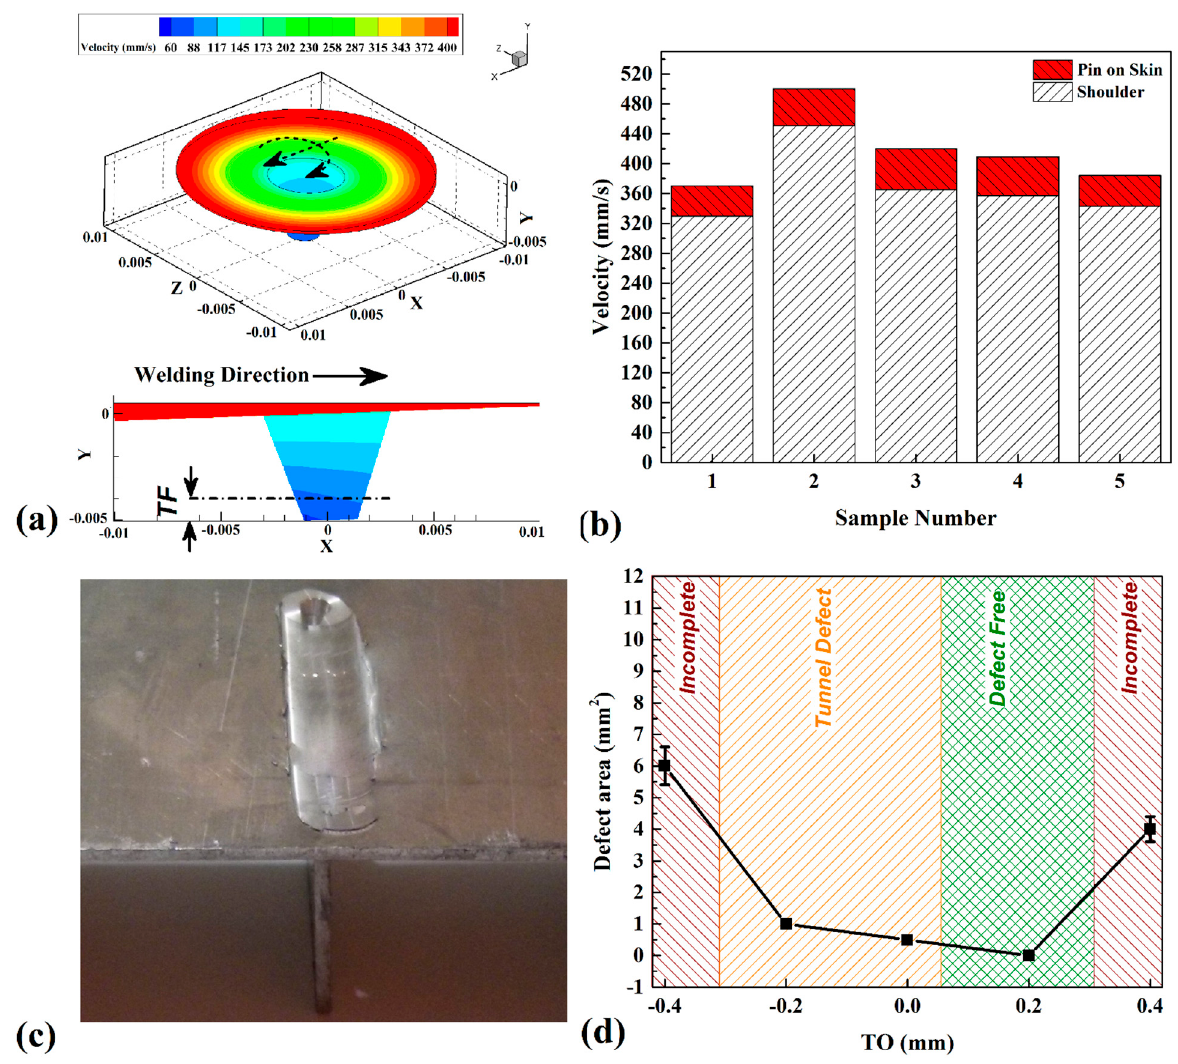
Figure 5. ( a ) Simulation results of materials velocity in SZ of case 3. ( b ) Simulation results of maximum materials velocity on skin and flange. ( c ) Welded sample case 2. ( d ) Relationship between TO and joint defects.